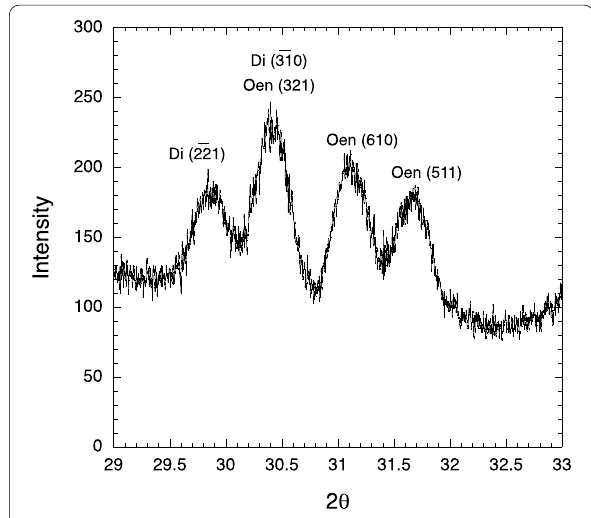
Fig. 8 X-ray diffraction of 2 theta, 29°–33°, showing peaks for orthoenstatite (Oen) and diopside (Di) in MS-177